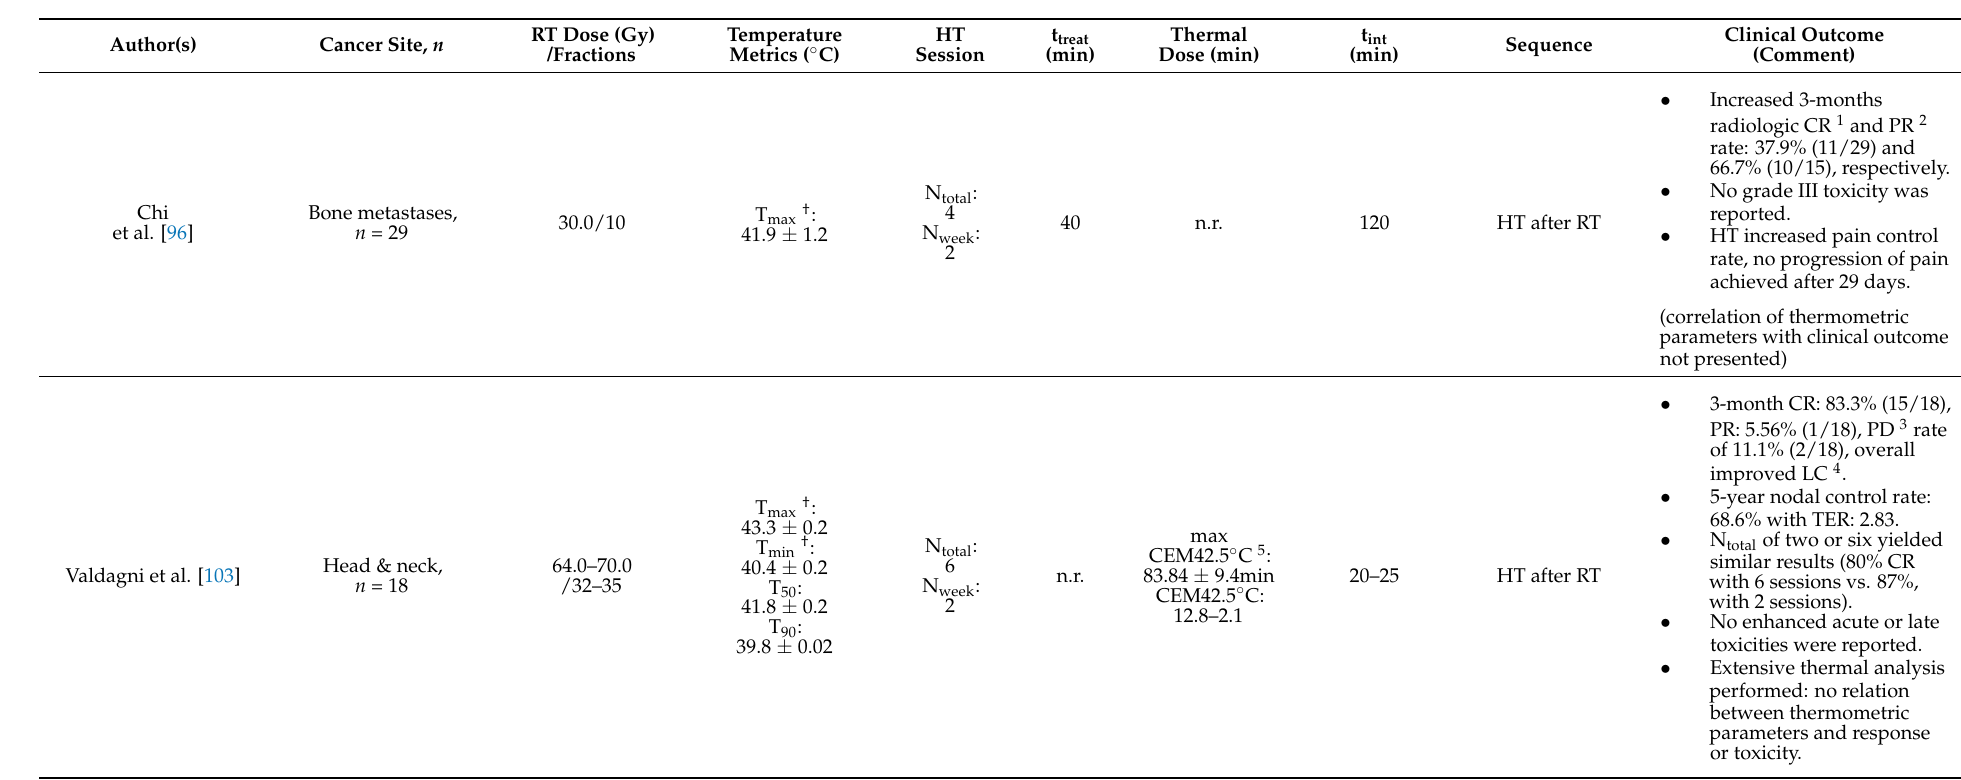
Table 7. Prospective clinical studies using RT in combination with